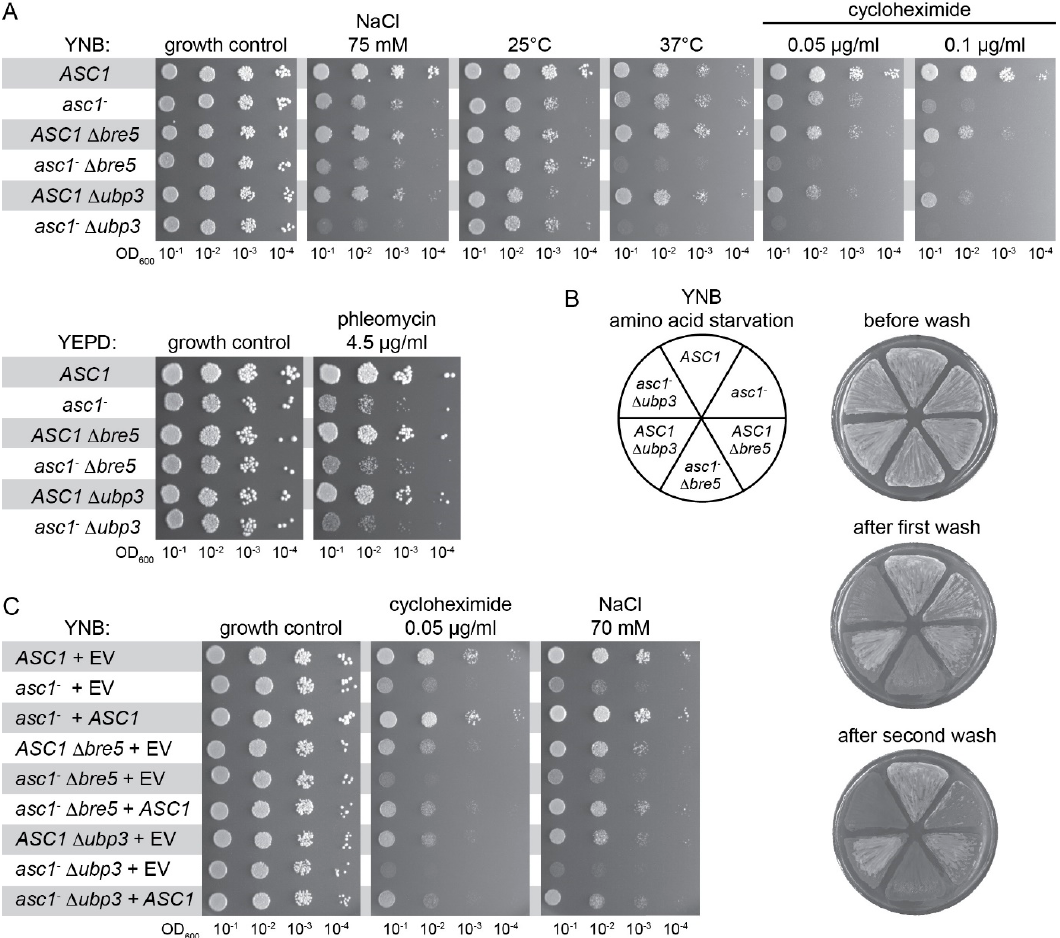
Figure 4. Genetic interaction between ASC1 and BRE5 / UBP3 . S. cerevisiae ASC1 , BRE5 , and UBP3 single and double deletion strains were phenotypically characterized. ( A ) Drop dilution assays were performed to test for sensitivity of the strains to cycloheximide, phleomycin, as well as to hyperosmotic stress (NaCl), cold stress (25 °C), and heat stress (37 °C). ( B ) Cells were grown on 3-AT containing plates to analyze adhesive growth. The plate was photographed before and after treatment with a constant stream of water (shorter and longer wash). ( C ) The asc1 − strain and the double deletion strains asc1 − ∆ bre5 and asc1 − ∆ ubp3 were complemented with plasmid-borne ASC1. As controls, the wild-type strain and all single and double deletion strains were transformed with the empty vector (EV). Drop dilution growth assays were performed to test for sensitivity to cycloheximide and hyperosmotic stress (NaCl).